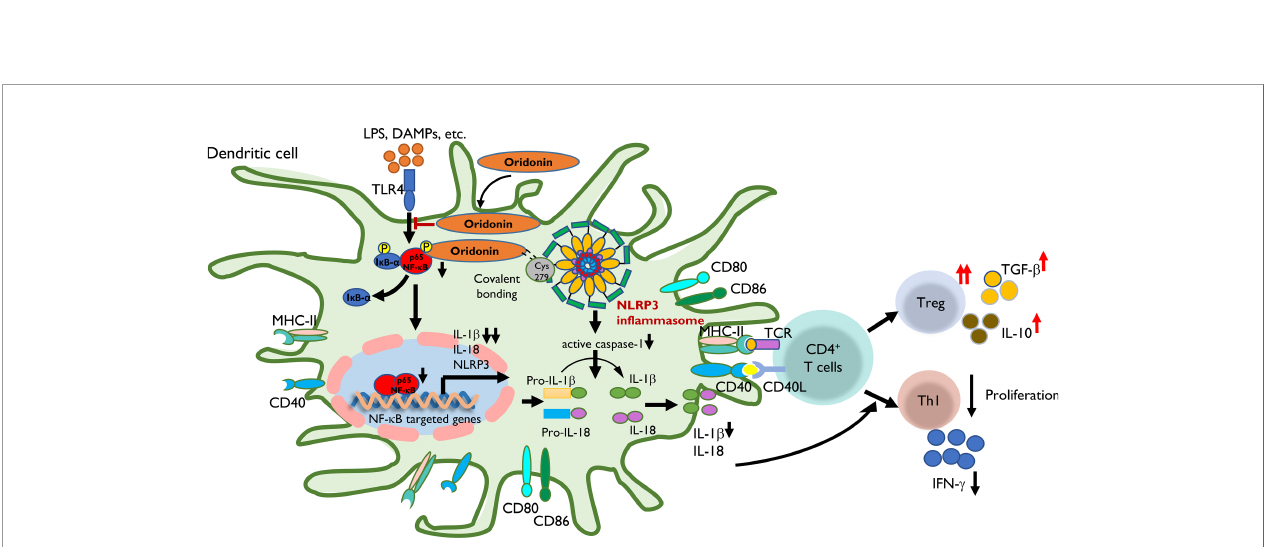
FIGURE 9 | The proposed mechanism by which Ori regulates the transplant immune response through the NLRP3/I k -B/NF- k B pathway. Step 1: LPS, DAMPs, etc. were recognized by TLR4 of DC and then induced the transcription of NLRP3, IL-1 b , and IL-18 through the I k -B/NF- k B pathway with the upregulating expression of MHC-II, CD40, CD80, and CD86. Step 2: Ori could bind to cysteine 279 of NLRP3 via covalent bond formation to prevent NLRP3 in fl ammasome interaction and the subsequent production of IL-1 b and IL-18. On the other hand, Ori could interact with the pathway of I k -B/NF- k B and prevented its activation. Step 3: In the subsequent immune responses, following the administration of Ori, the activated DC induced the alternation in naïve T-cell differentiation to expand Tregs along with increased cytokines of TGF- b and IL-10, and downregulate Th1 cells with the reduced secretion of IFN- g . In summary, the functional outcome is to suppress the cellular immune